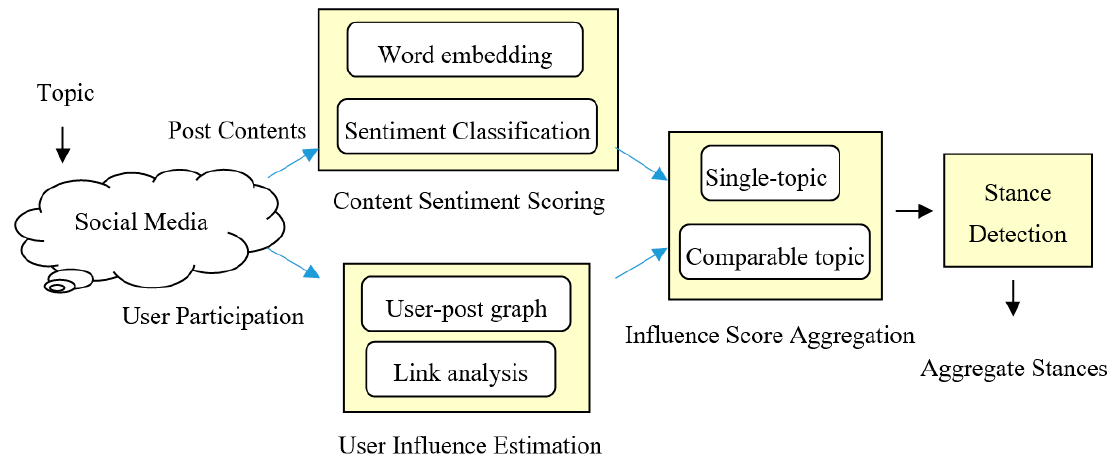
Figure 1. The system architecture of the proposed approach.